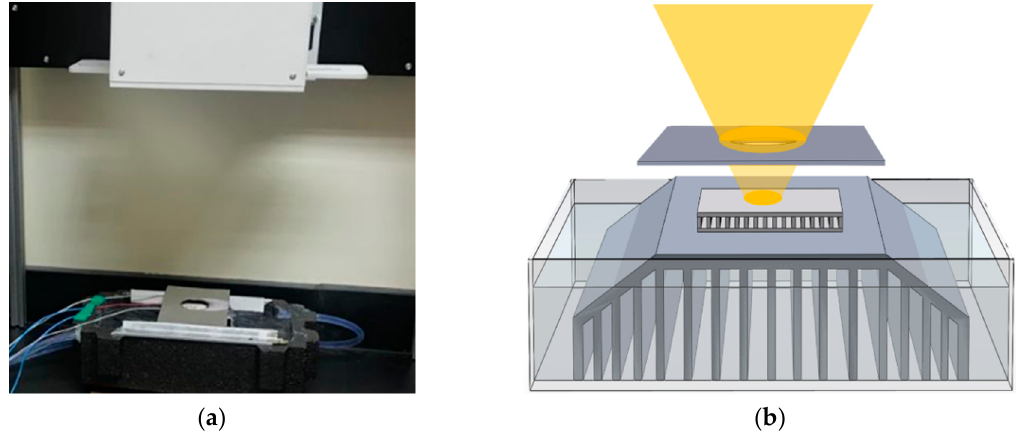
Figure 1. Photo ( a ) and sketch ( b ) of the setup used.